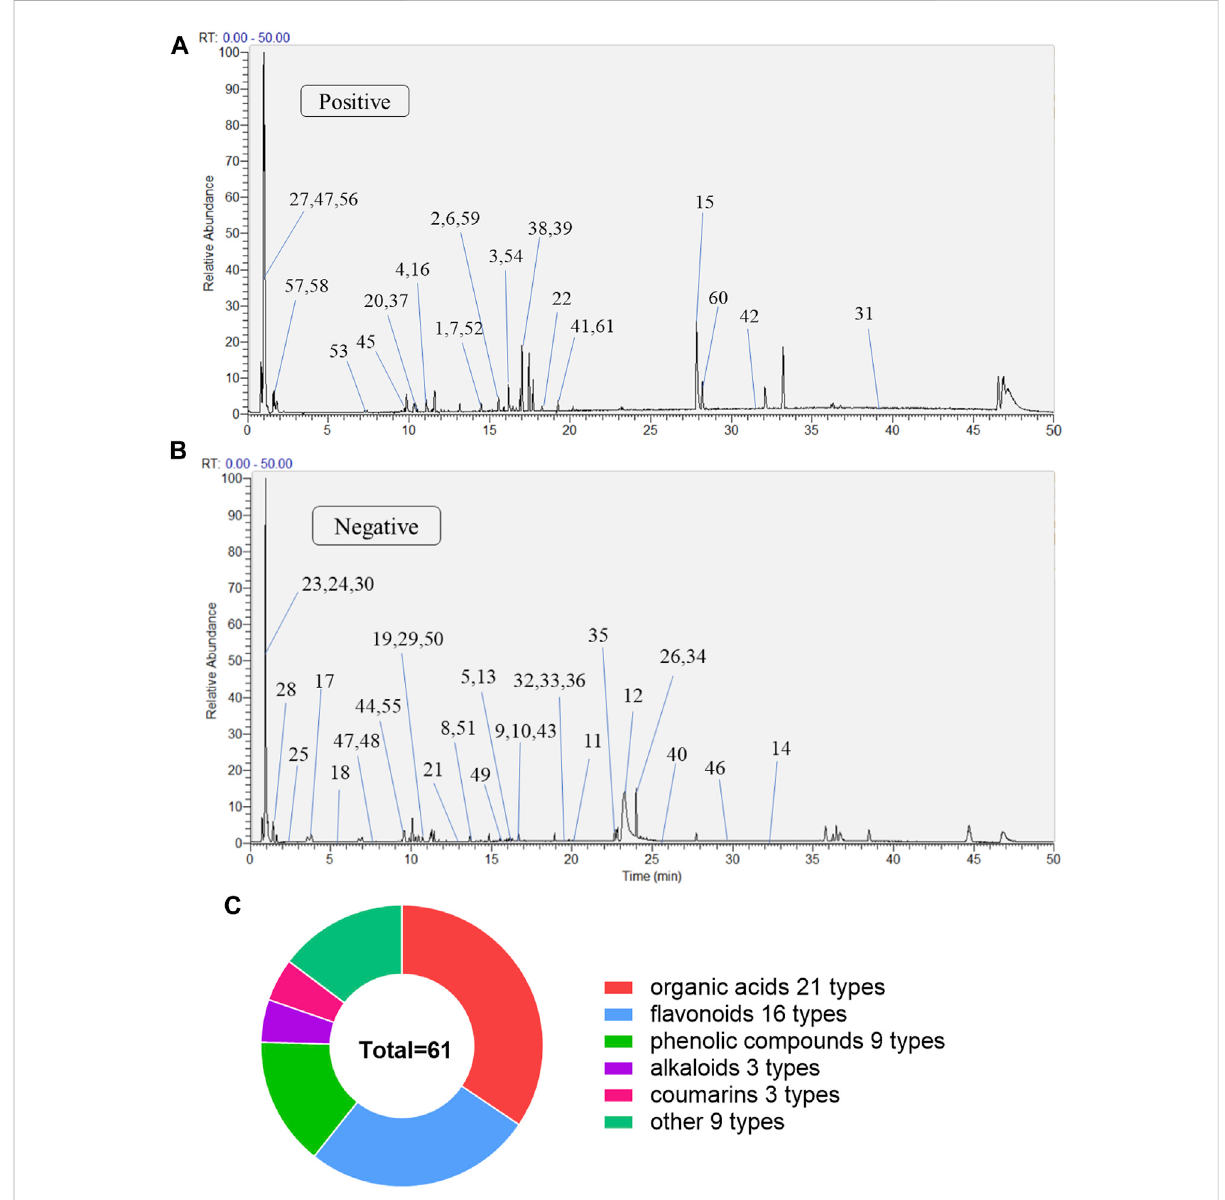
FIGURE 1 The compositions of MLs were determined by UPLC-Q-Exactive Orbitrap-MS (A) Total ion fl ow diagram of MLs in a positive mode (B) Total ion fl ow diagram of MLs in a negative mode (C) Number of monomer components in MLs identi fi ed by positive and anion UPLC-Q-Exactive